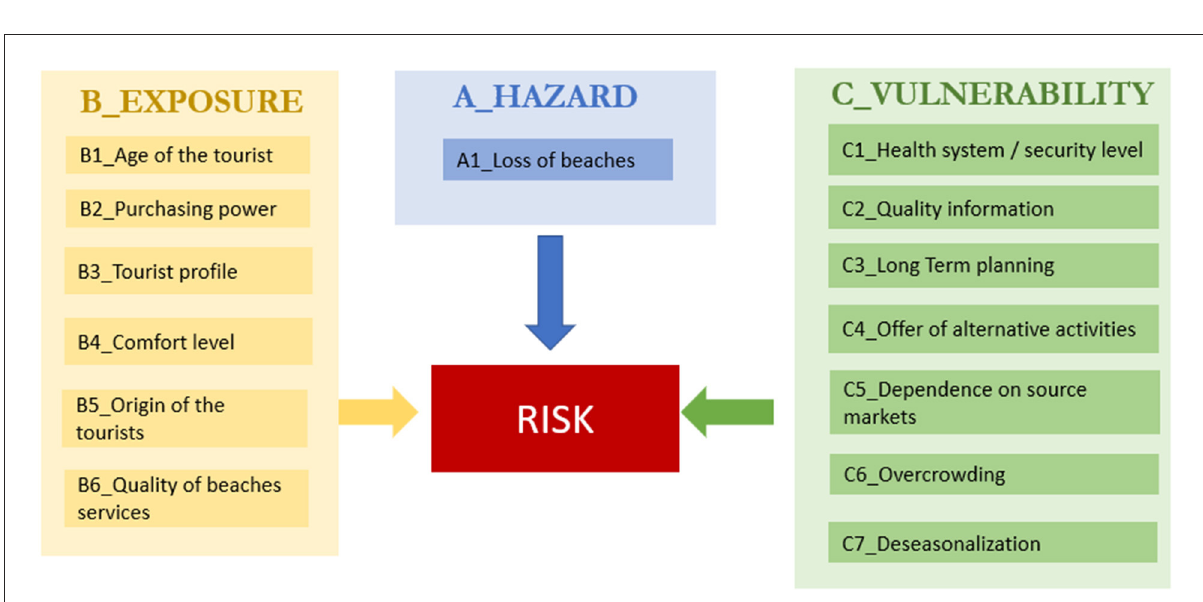
FIGURE5 Impact chain 2, corresponding to the “Risk of loss of attractiveness due to a reduction of beach